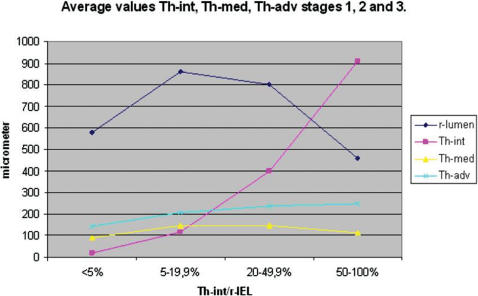
Line diagram mean thickness- intima (Th-int), -media (Th-med), -adventitia (Th-adv) For Th-int/r-IEL (thickness intima/radius Internal Elastic Lamina) reference and stages.